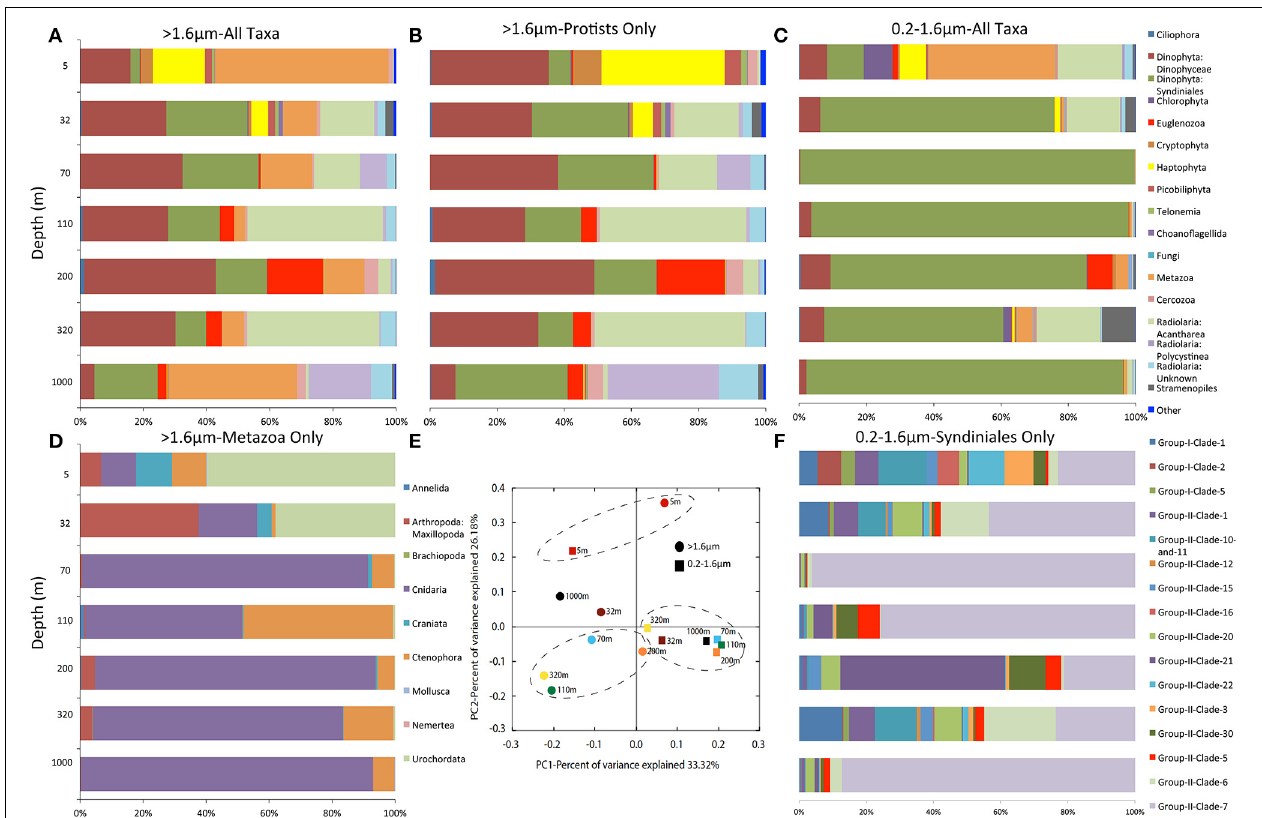
FIGURE 2 | Community taxonomic composition in the (A) > 1.6 µ m fraction based on all 18S rRNA gene sequences. (B) > 1.6 µ m fraction with metazoan sequences excluded. (C) 0.2–1.6 µ m fraction based on all sequences. (D) > 1.6 µ m fraction based only on sequences matching